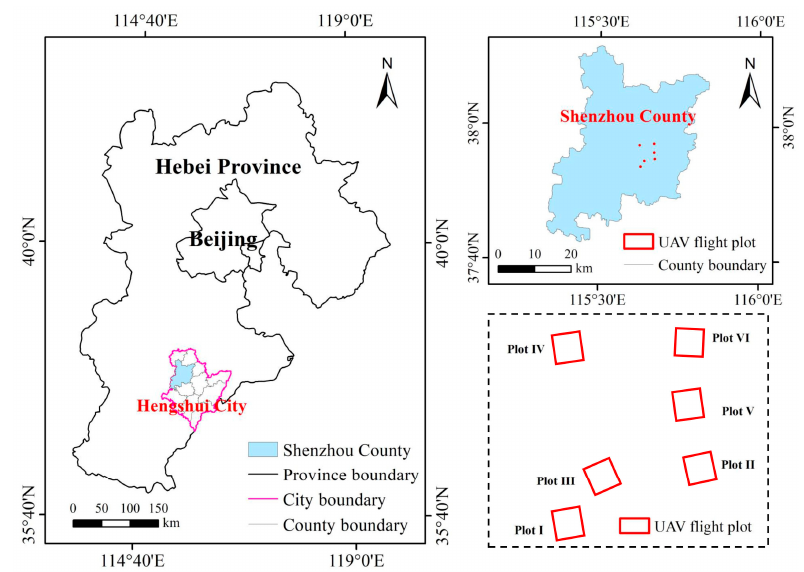
Figure 1. Location of the study area and distribution of UAV flight plots.